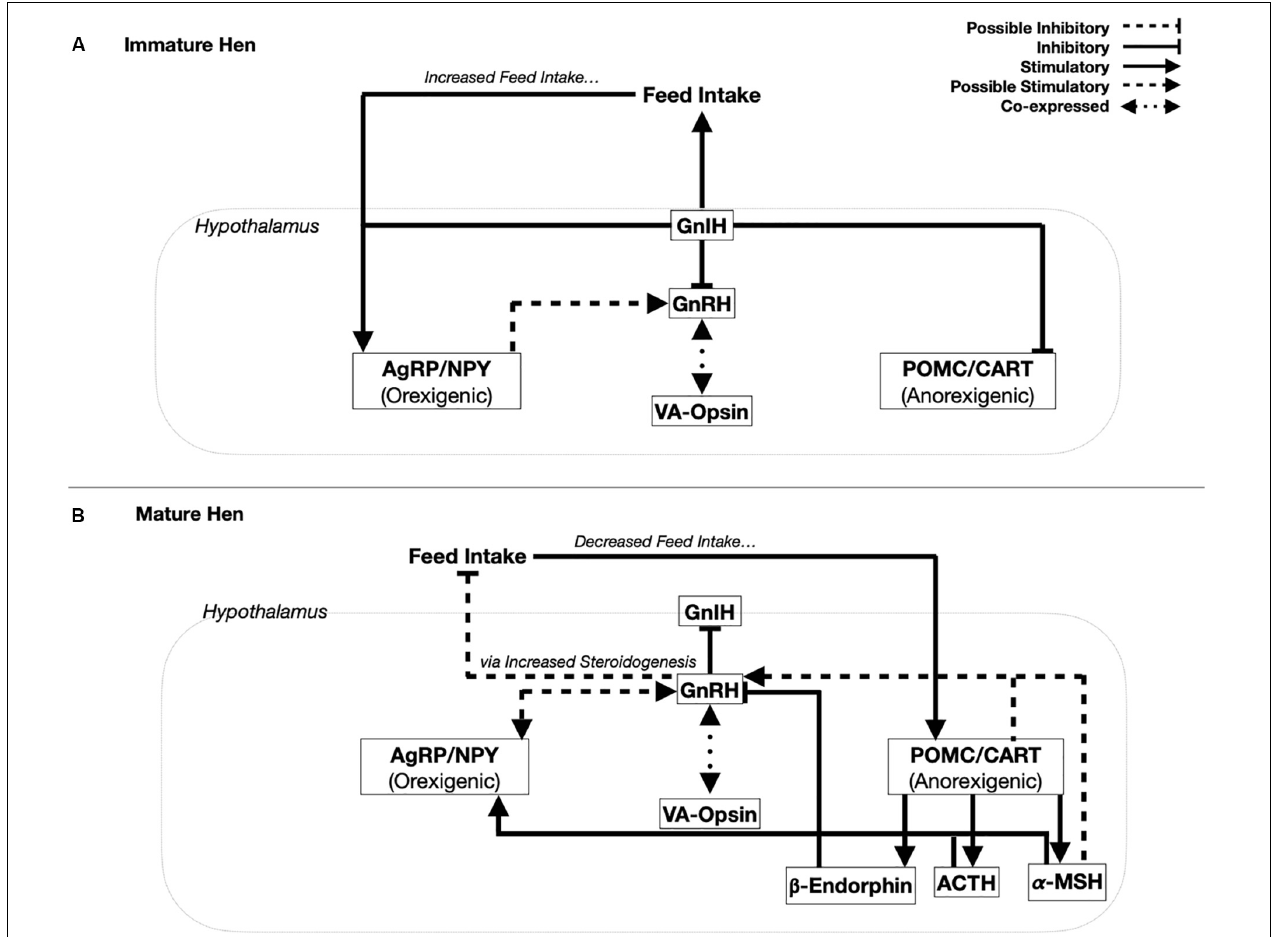
FIGURE 1 | Proposed integration of the hypothalamic control of reproduction with the melanocortin system. While the hen is in an immature state (A) , Gonadotropin-inhibitory hormone (GnIH) is the primary neuropeptide released by the hypothalamus. GnIH simultaneously stimulates orexigenic peptides, agouti-related peptide (AgRP), and Neuropeptide Y (NPY), while inhibiting the anorexigenic peptides, pro-opiomelanocortin (POMC), and cocaine-and amphetamine regulated transcript (CART). Additionally, GnIH stimulates feed intake during a period of growth, also linked to AgRP and NPY upregulation. Recent evidence suggests that AgRP and NPY have the ability to stimulate gonadotropin-releasing hormone (GnRH), which may in turn activate the HPG axis. However, with the co-expression of vertebrate ancient (VA)-opsin and GnRH, this may be the primary site for mediating the effects of photoperiod. In the mature hen (B) , GnRH inhibits the production of GnIH and is proposed to decrease feed intake via an increase in steroidogenic activity. A decrease in feed intake stimulates POMC and CART activity, with POMC cleaved into 3 peptides, β -endorphin, adrenocorticotropin hormone (ACTH), and alpha-melanocortin-stimulating hormone ( α -MSH). ACTH and α -MSH are able to stimulate AgRP and NPY. Meanwhile, CART, along with ACTH and α -MSH have been hypothesized to positively feedback on GnRH to stimulate the HPG axis. However, POMC cleavage may be critical in this control with β -endorphin established to inhibit GnRH